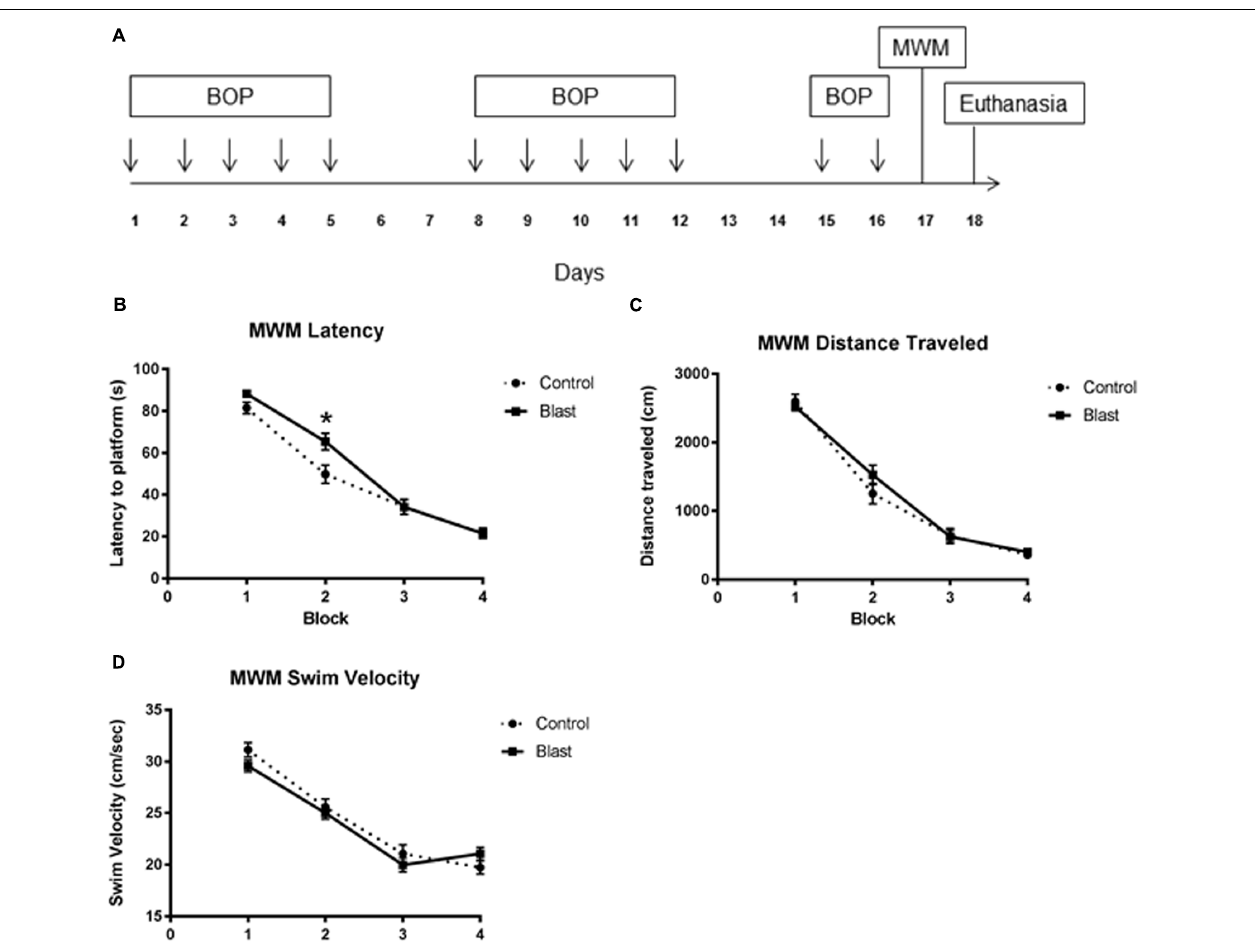
FIGURE 1 | Repeated blast exposure caused performance decrements in the Morris Water Maze. Schema representing the experimental design for experiment 1 (A) . Each arrow represents an individual blast overpressure exposure (BOP). Line graphs represent mean MWM trial performance over four consecutive blocks of trials. Each block consisted of four swim trials. Blast exposed animals (solid line) had significantly increased latency to platform (B) when compared to controls (dashed line) (52.3 s vs. 46.8 s, two-way ANOVA, p = 0.0418). Swim velocity (24.38 cm/s vs. 23.91 cm/s, two-way ANOVA, p = 0.3359) (D) and Distance traveled (1214 cm vs. 1269 cm, two-way ANOVA, p = 0.4443) (C) were not significantly different between